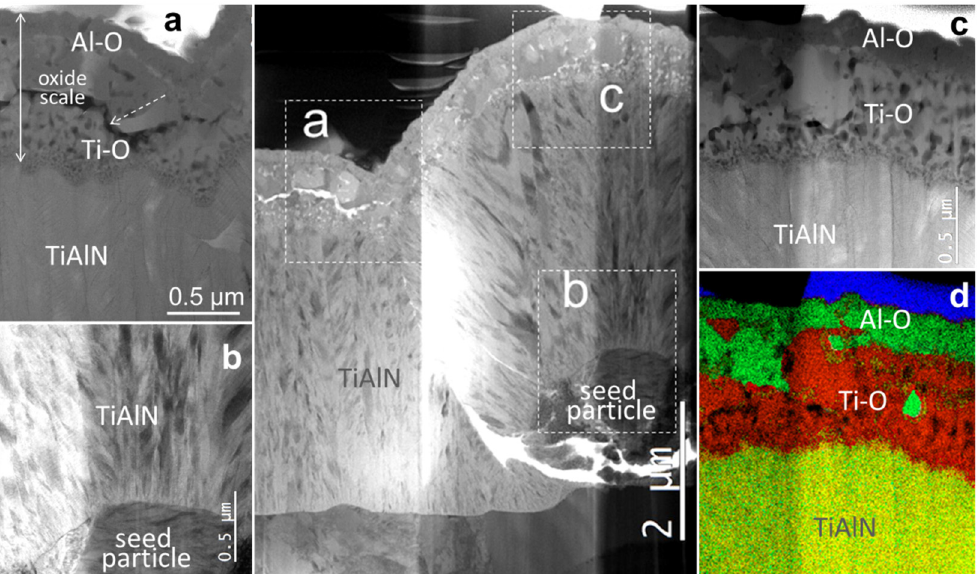
Figure 16. Bright-field STEM cross-sectional image of nodular defect ( a – c ) and corresponding STEM-EDS map ( d ) of TiAlN coating oxidized at 850 °C for 60 min.